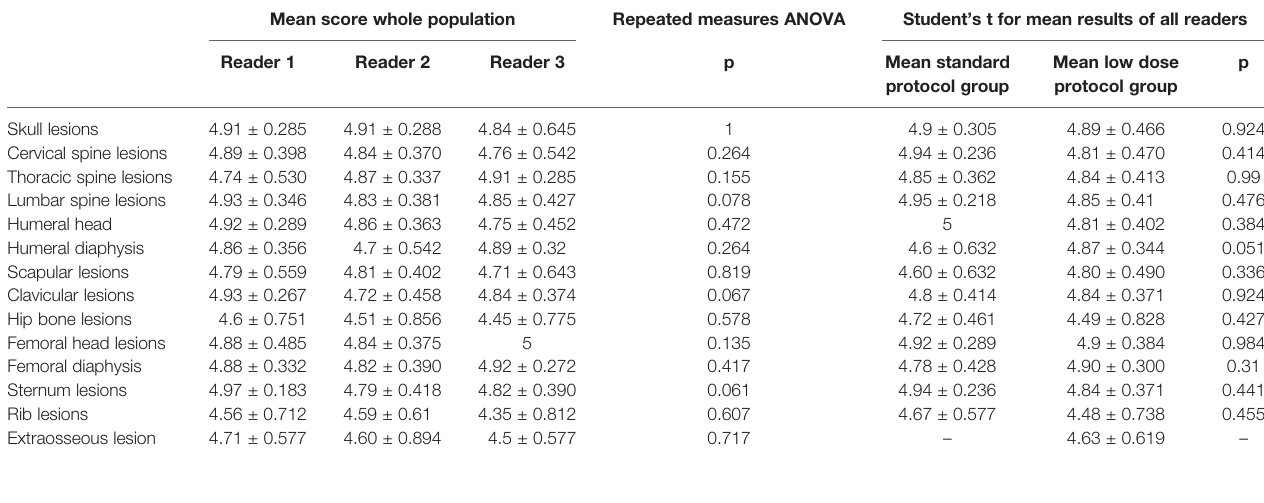
TABLE 5 | Mean results for whole population Likert scores on diagnostic con fi dence for osteolytic lesions detection and comparison of mean scores for both groups.